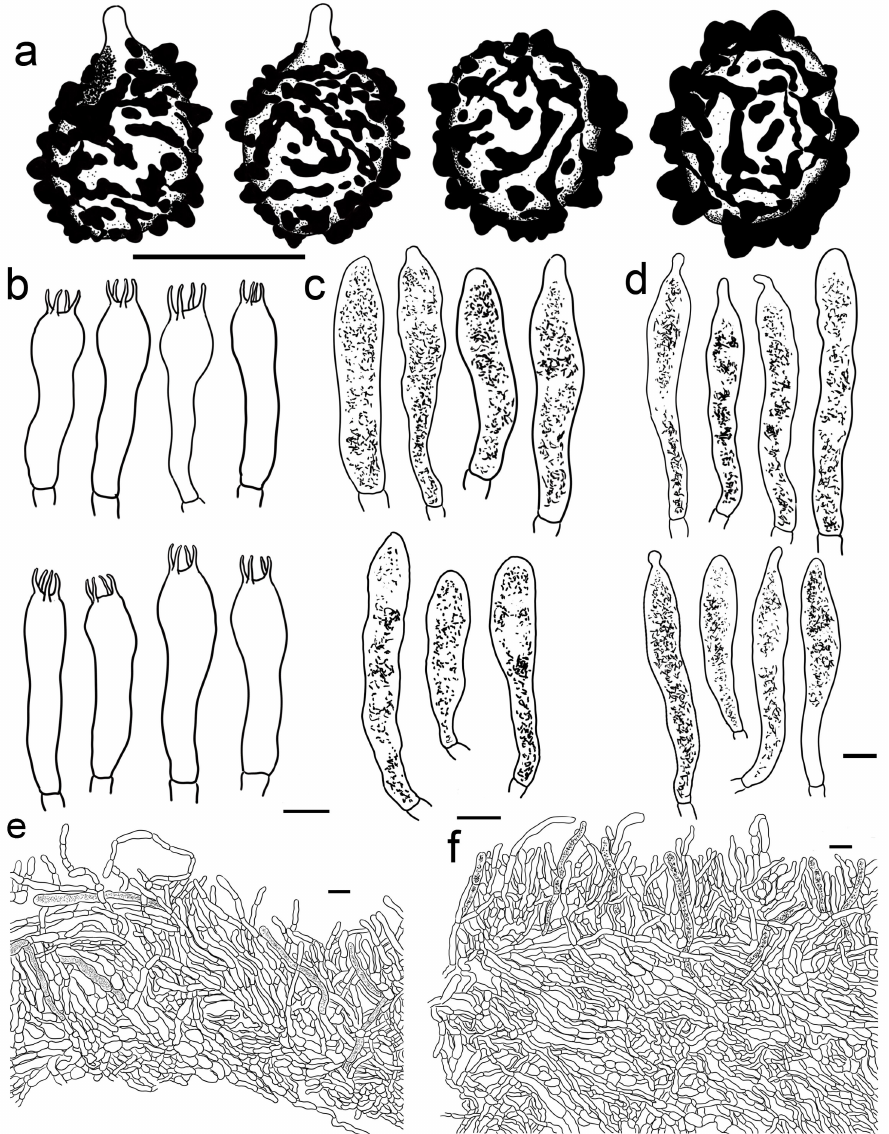
Figure 9. Russula photinia (HBAU15536, Holotype). ( a ) Basidiospores . ( b ) Basidia . ( c ) Cheilocystidia . ( d ) Pleurocystidia . ( e ) Suprapellis and partial subpellis in pileus centre. ( f ) Suprapellis and partial subpellis in pileus margin. Bars: ( a ) = 5 µ m, ( b – f ) = 10 µ m. Fungal Names: FN